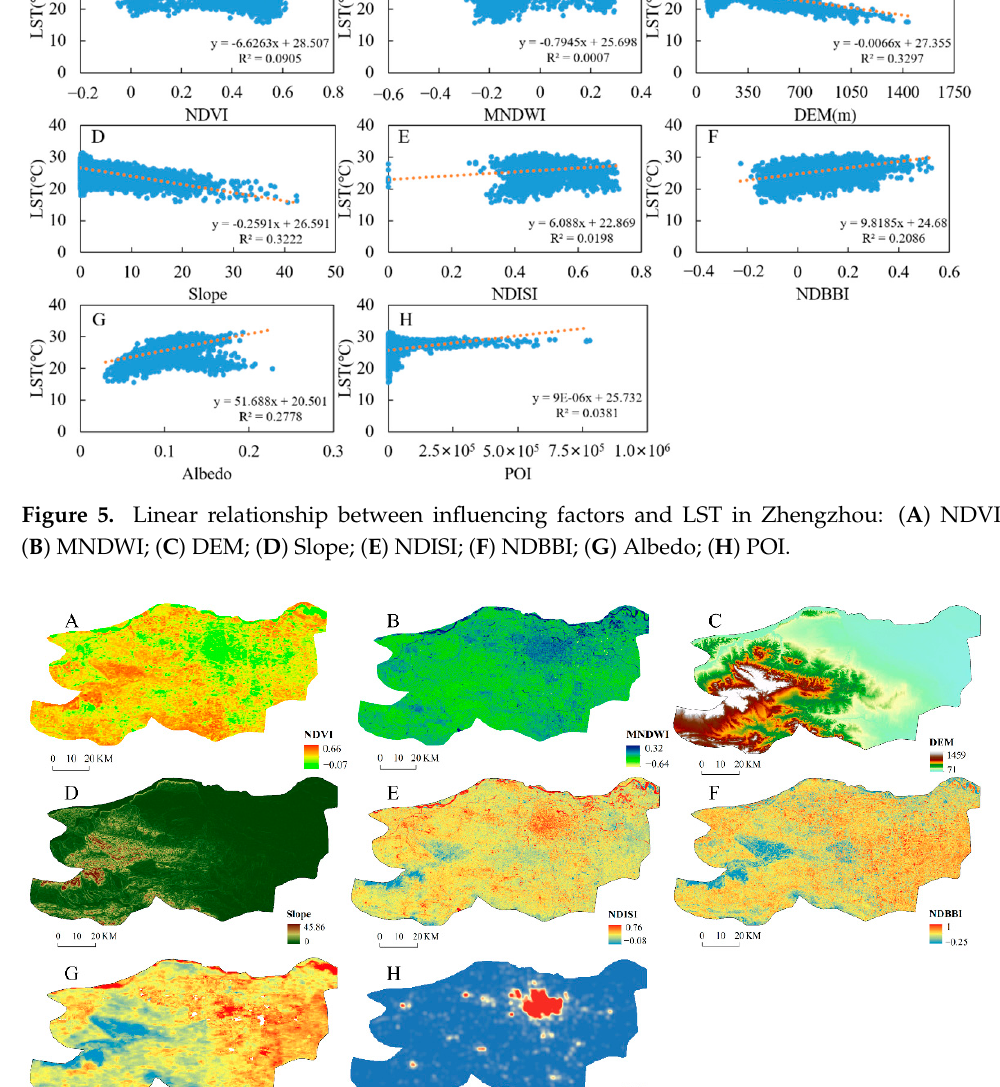
Figure 6. Spatial distribution of indicators in Zhengzhou: ( A ) NDVI; ( B ) MNDWI; ( C ) DEM; ( D ) Slope; ( E ) NDISI; ( F ) NDBBI; ( G ) Albedo; ( H ) POI. ( E ) NDISI; ( F ) NDBBI; ( G ) Albedo; ( H )